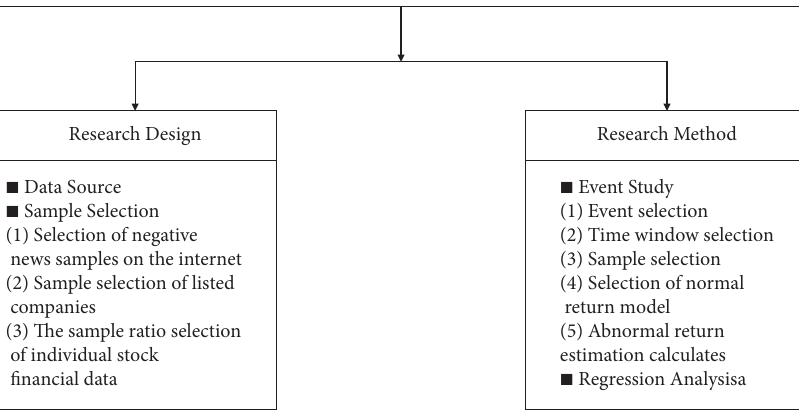
Figure 1: Path analysis chart of network negative news on abnormal fluctuation of stock